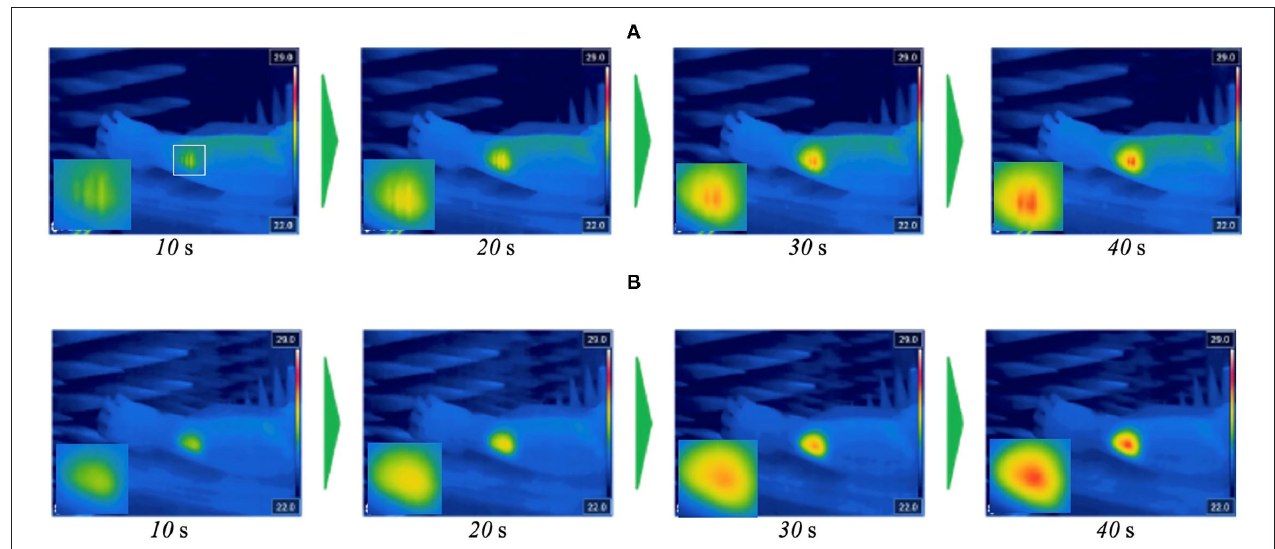
FIGURE 7 | Temperature distribution on arm-shaped phantom during the exposure to 60 GHz MMW at 2W of total antenna input power. (A) Orthogonally polarized feed. (B) Copolarized feed.